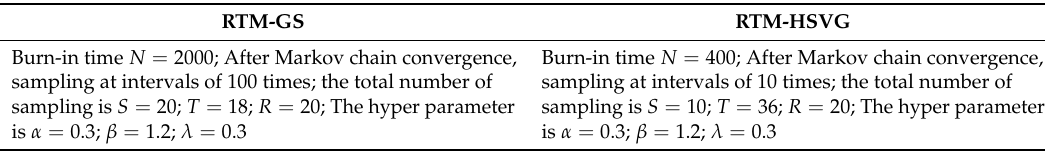
Table 2. Parameter settings of RTM-HSVG and RTM-GS.